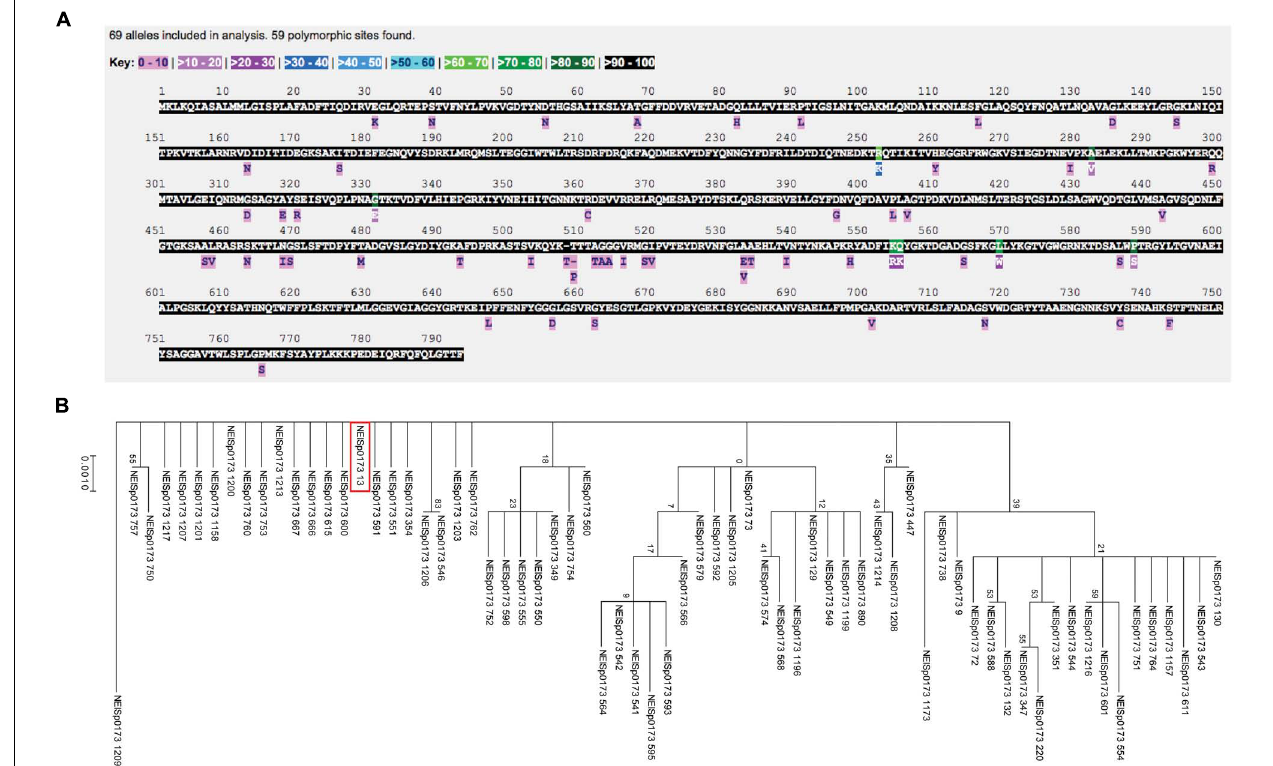
FIGURE 4 | Polymorphism and phylogenetic analyses of N. gonorrhoeae BamA. (A) Analysis of the NEISp0173 locus revealed 69 variants with 59 amino acid polymorphisms across 3,946 isolates for which sequence data has been deposited. (B) Phylogenetic analyses of BamA across N. gonorrhoeae showed numerous closely related variants, with several clusters present in the tree. The majority ( > 94%) of BamA diversity was found in the combination of variant 13 (noted by a red box) with five other